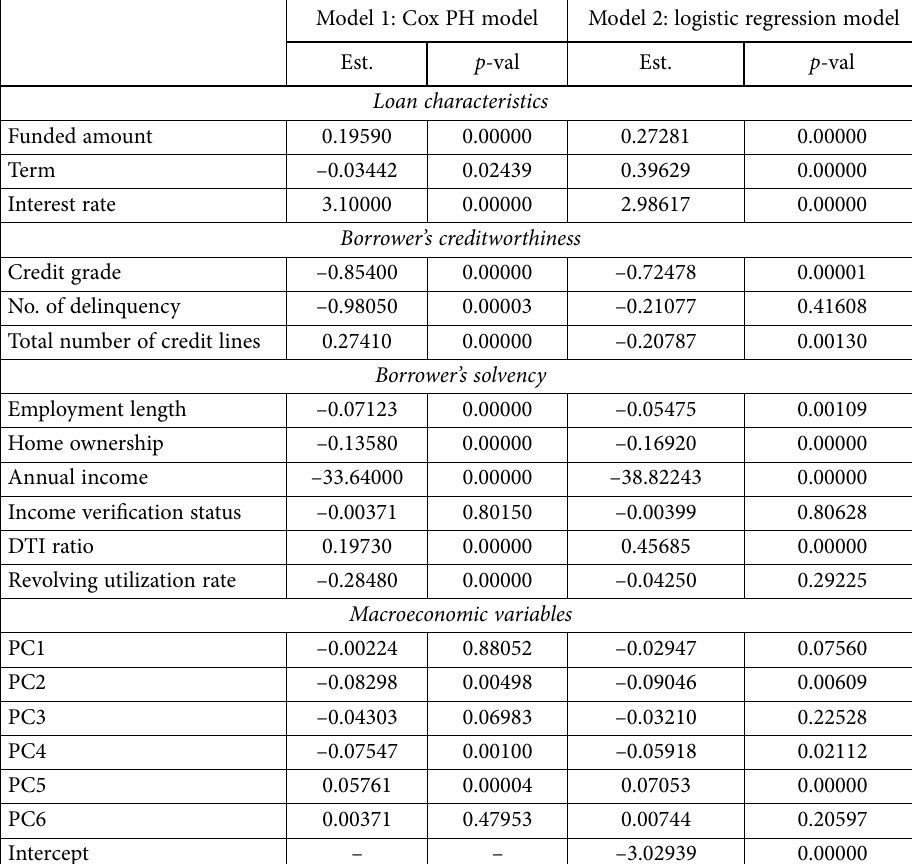
Figure 5. Out-of-time validation results of misclassification cost Table 6. Parameter estimates for Cox PH and logistic regression